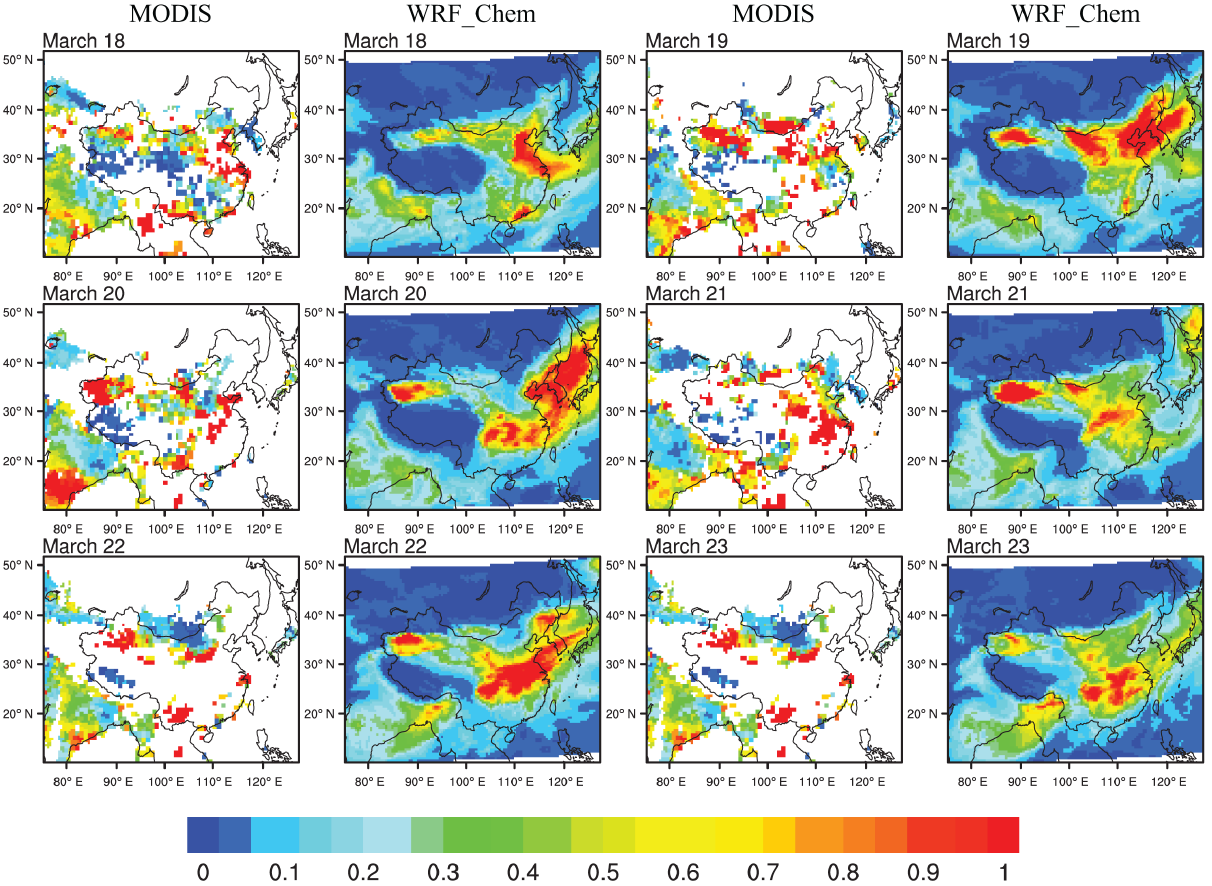
Figure 4. Spatial distributions of the daily mean 550nm aerosol optical depths from the MODIS retrievals and the corresponding WRF-Chem simulations over East Asia during the simulation period.